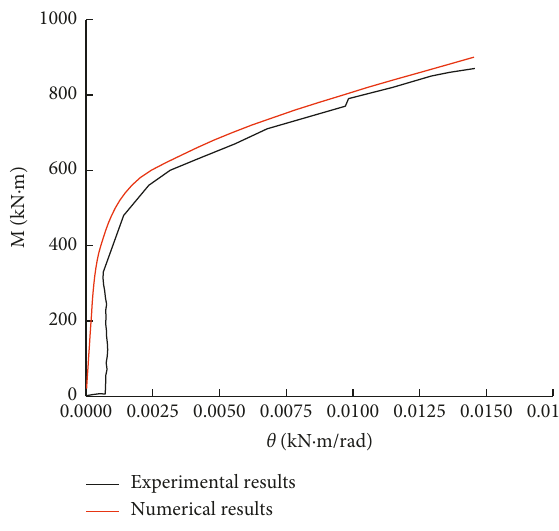
Figure 12: Comparison of moment-rotation curves of experi- mental and numerical